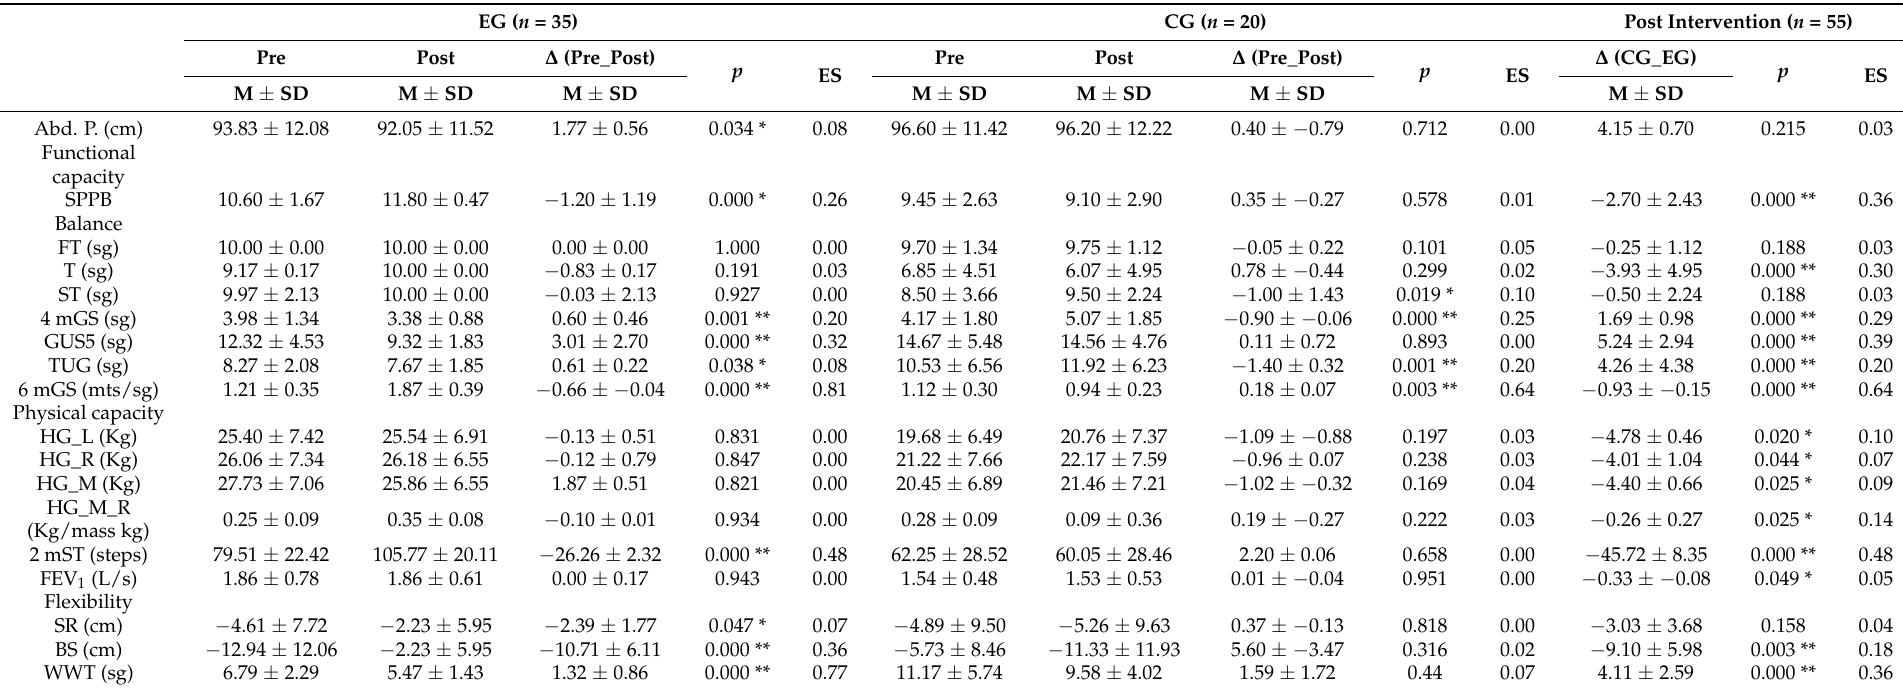
Table 3. Mean values obtained for functional capacity and physical capacity before and after MPTP in each of the